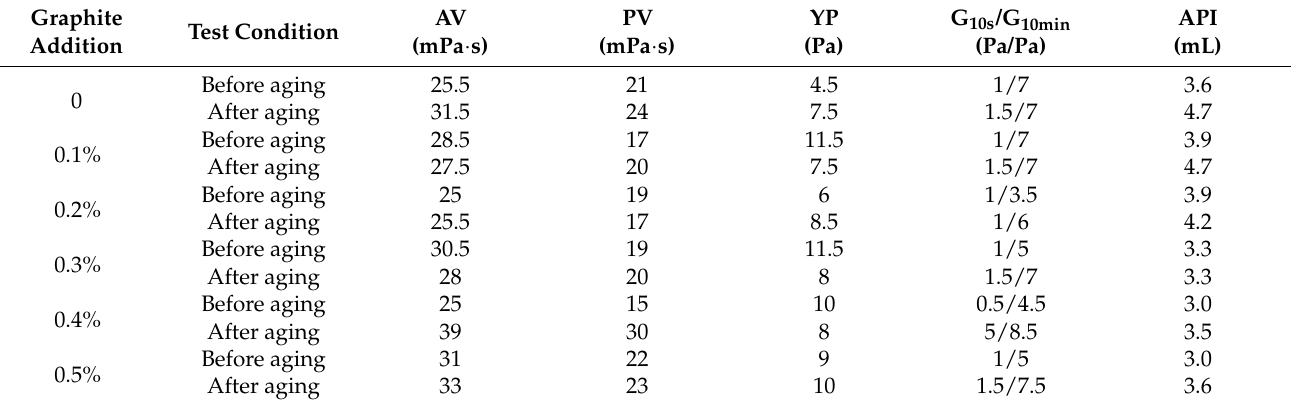
Table 11. Effect of elastic graphite on rheology and filtration of drilling